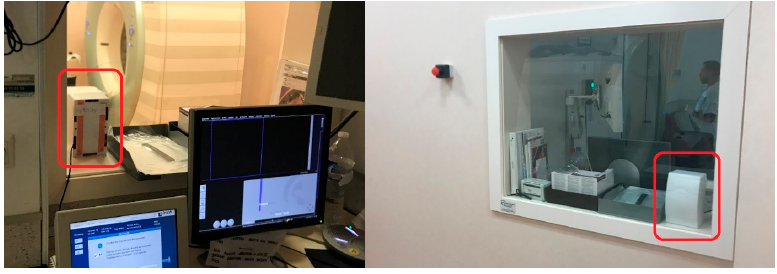
Figure 22. Device placed next to the CT room.